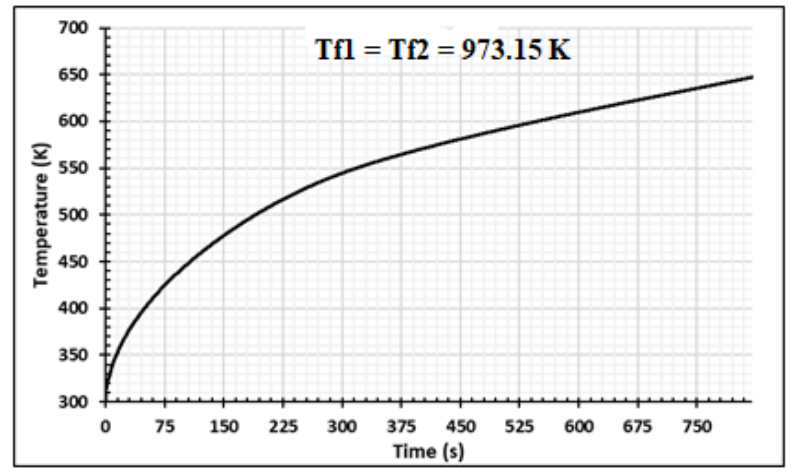
Figure 7. The wood average temperature at Tf = 973.15 K using samples of 30 mm thickness, ρ bo = 700 kg/m 3 .